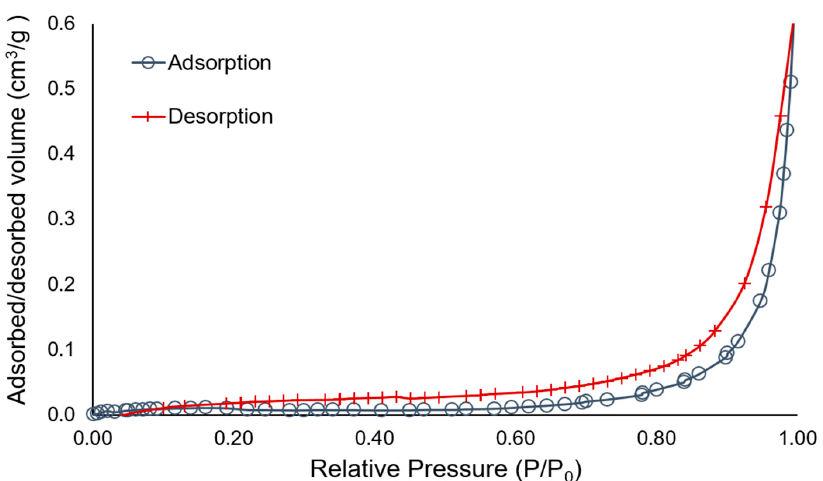
Figure 1. Nitrogen adsorption–desorption isotherms for coffee waste from A company depending on the relative pressure.